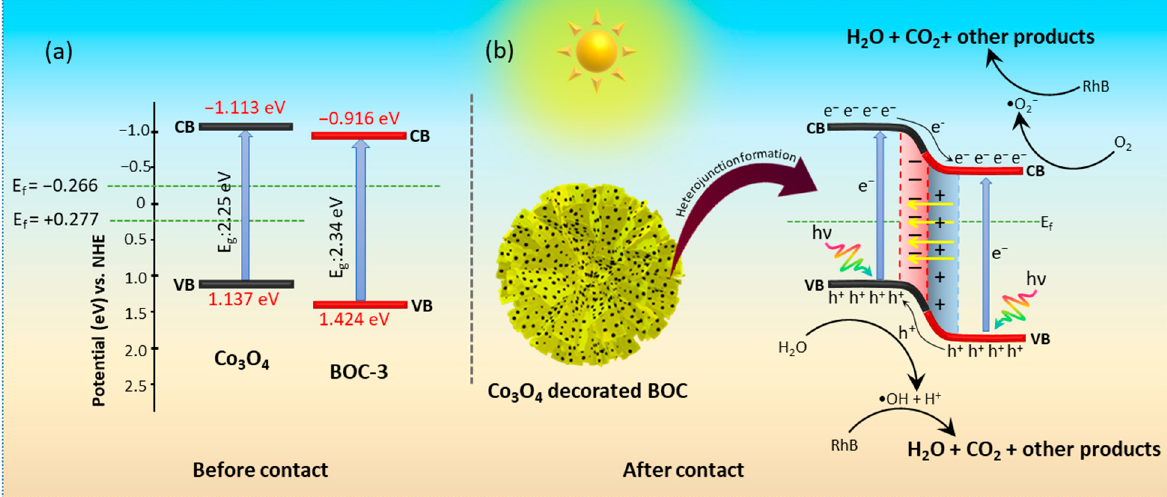
Figure 6. ( a ) Energy-level diagrams of Co 3 O 4 and BOC and ( b ) interfacial charge transfer behavior and redox reaction process in 20-Co 3 O 4 /BOC heterostructure under visible-light irradiation.